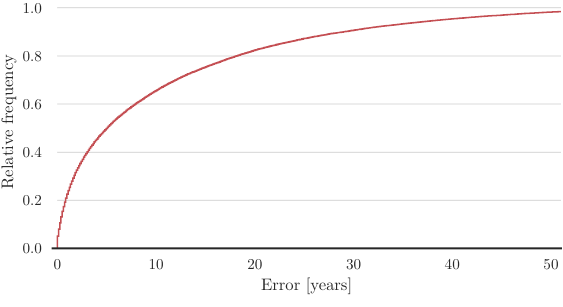
Figure 6. Cumulative histogram of estimation errors for model